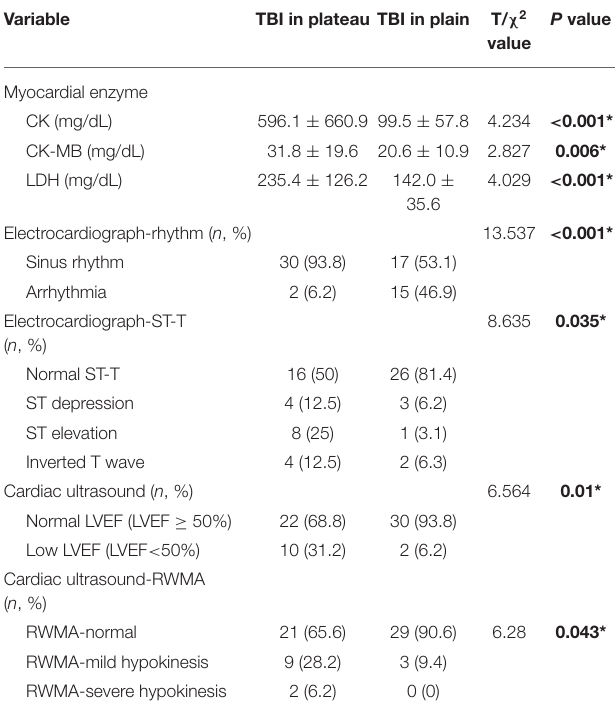
TABLE 6 | Cardiac function of patients with TBI in plateau and plain areas.